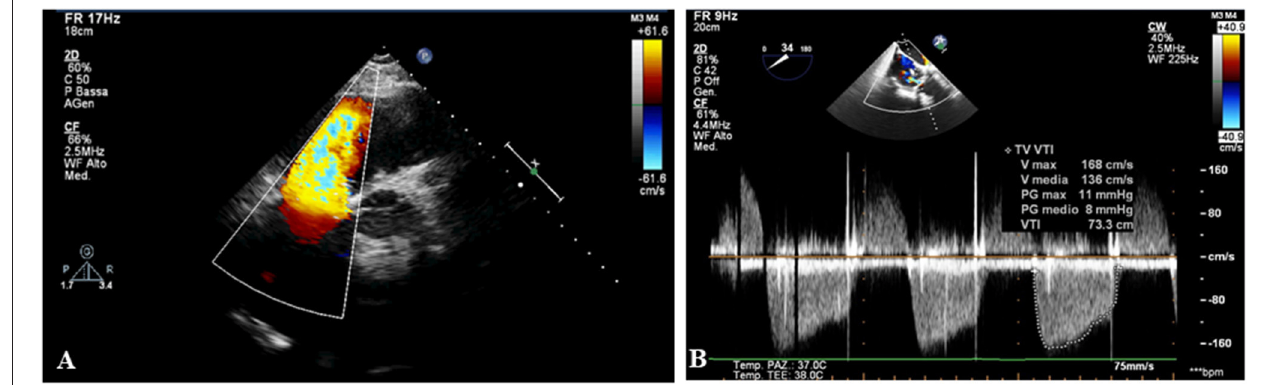
FIGURE 1 | The echocardiography shows a degeneration of tricuspid biological prosthesis with severe regurgitation (A) and stenosis (B) .